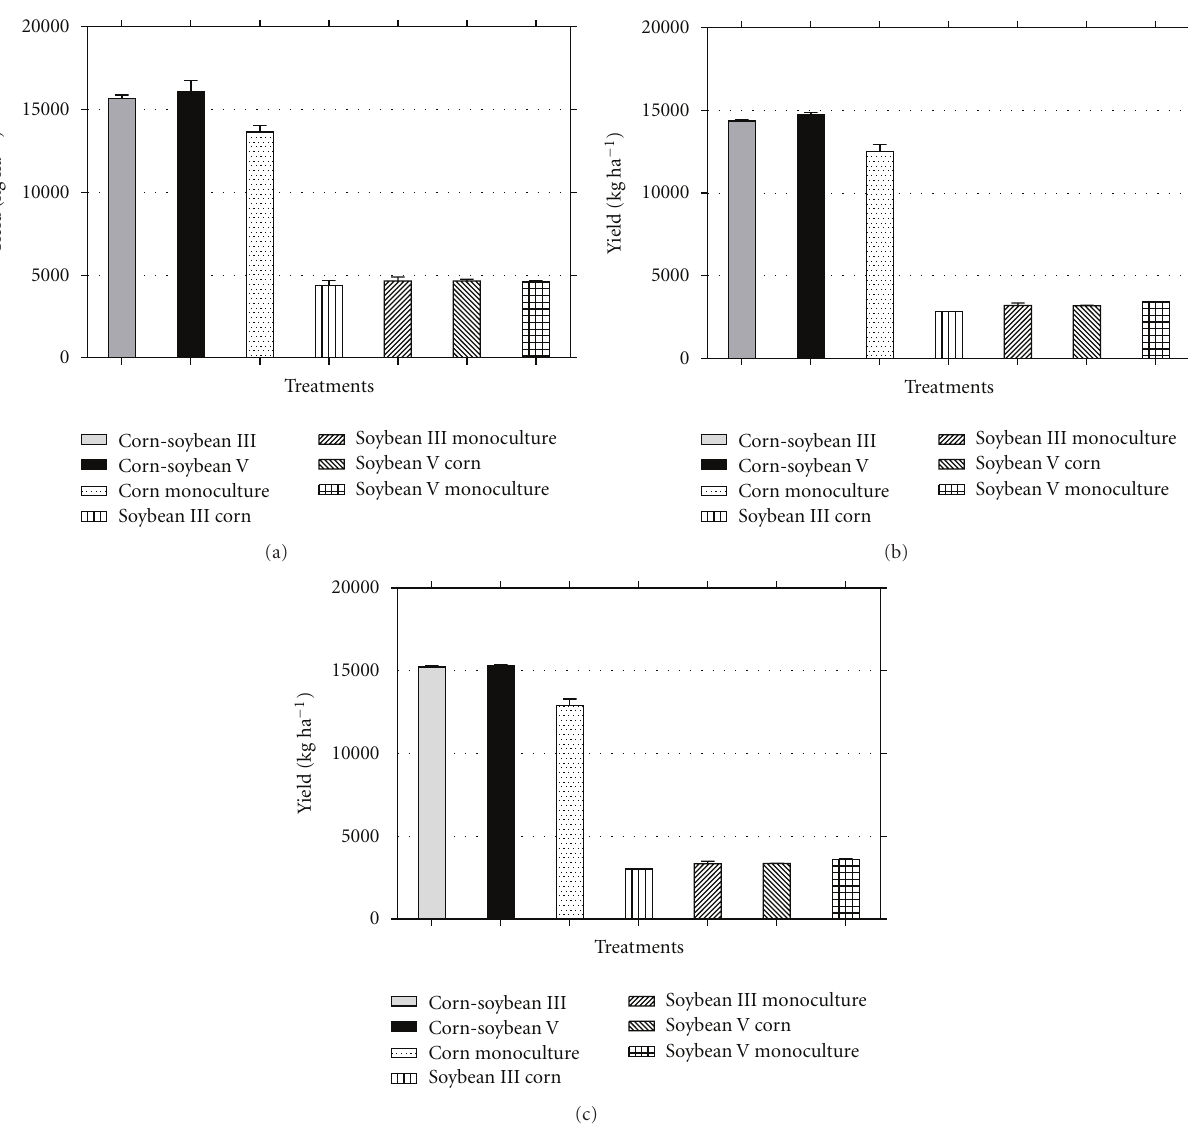
Figure 4: Crop yields in monocultures and in intercropped in C1 (a), C2 (b), and C3